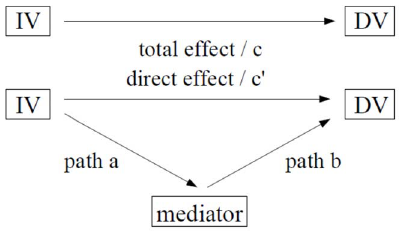
Figure 1. Paths of mediation analysis. doi:10.1371/journal.pone.0091285.g001 PLOS ONE |